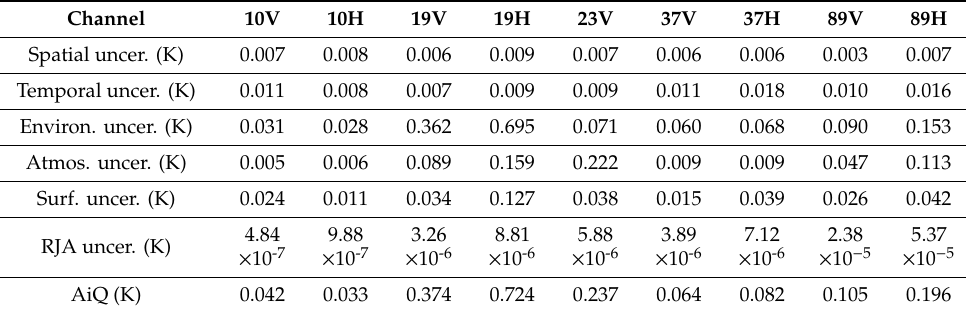
Table 5. Summary of derived individual uncertainty from all sources.